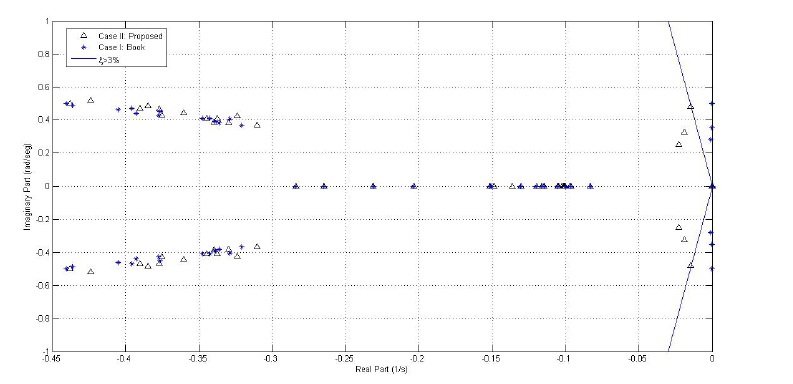
Figure 34. Eigenvalues in light load operation